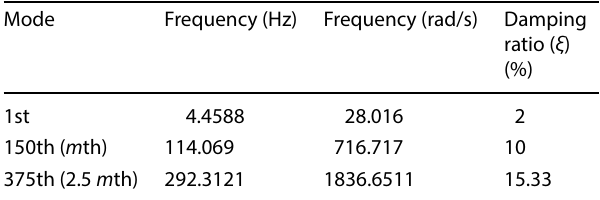
Table 5 Damping ratio for m th and 2.5 m th mode